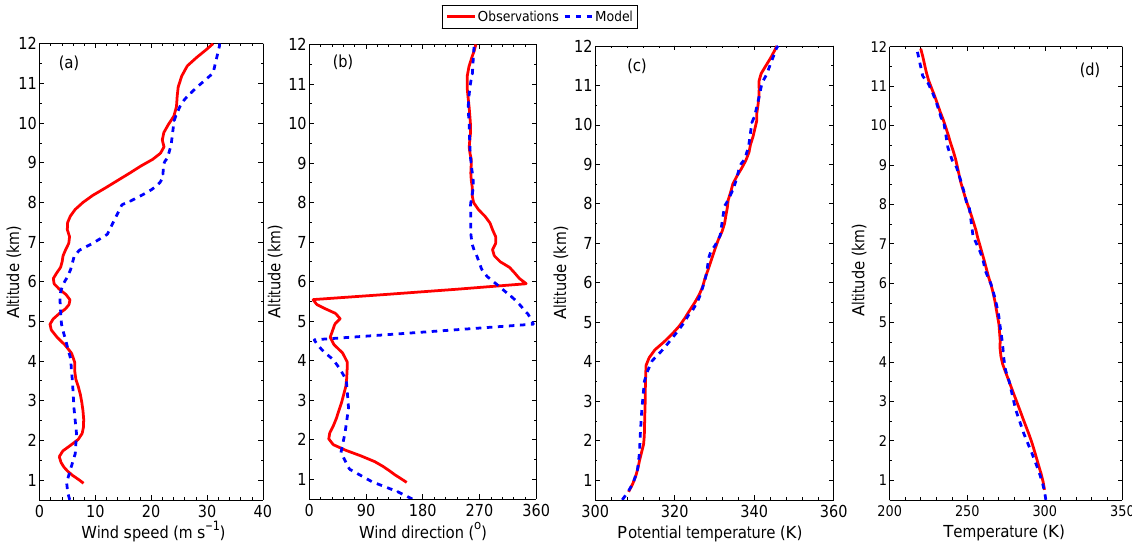
Figure 3. Comparison between the model-simulated meteorological variables in the “No ACEM” (control) run and the corresponding obser- vations over the balloon flight region on 17 March 2010 for (a) wind speed, (b) wind direction, (c) potential temperature and (d)